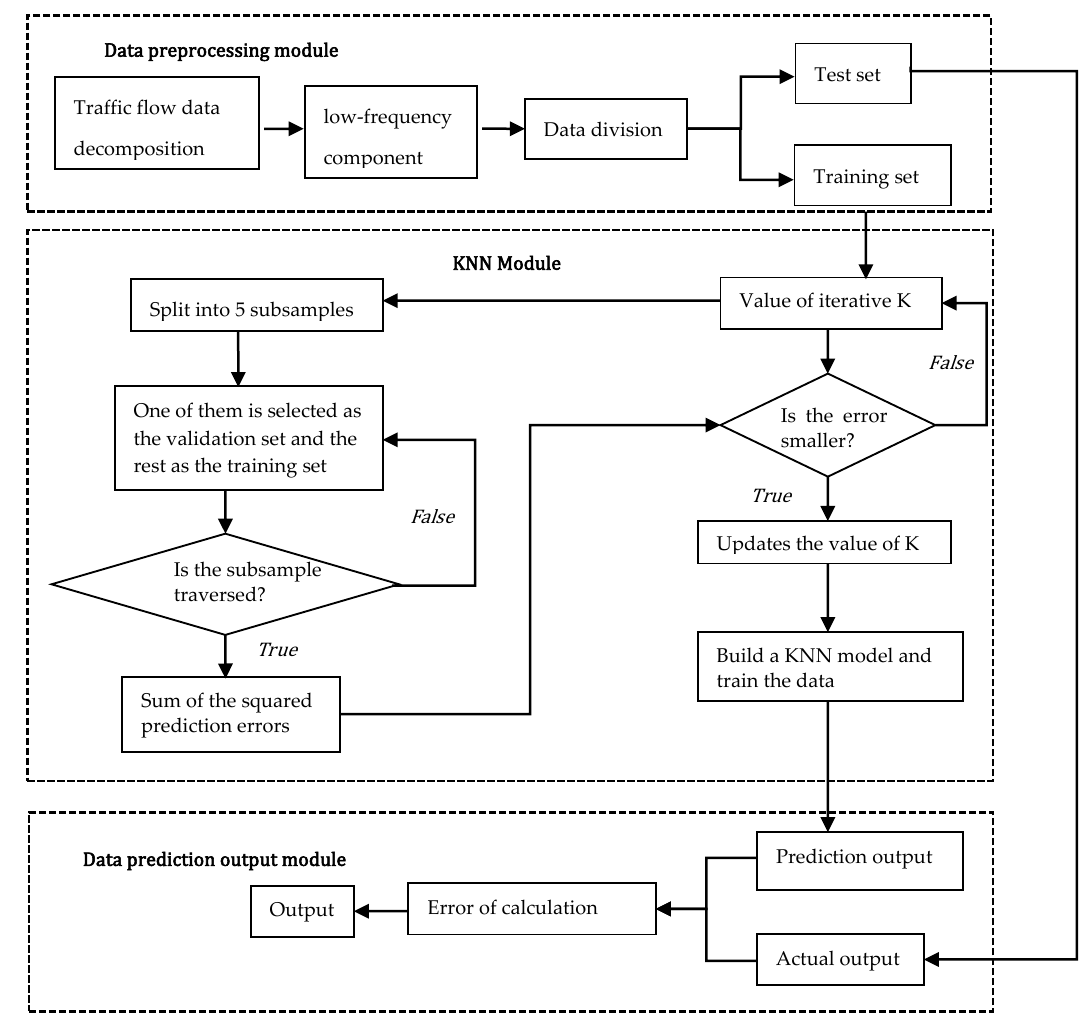
Figure 3. Flowchart of low-frequency component prediction based on KNN.